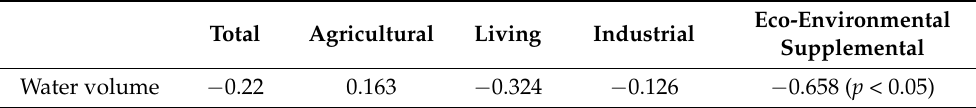
Table 5. Correlation coefficient between different water consumption and water volume. Total